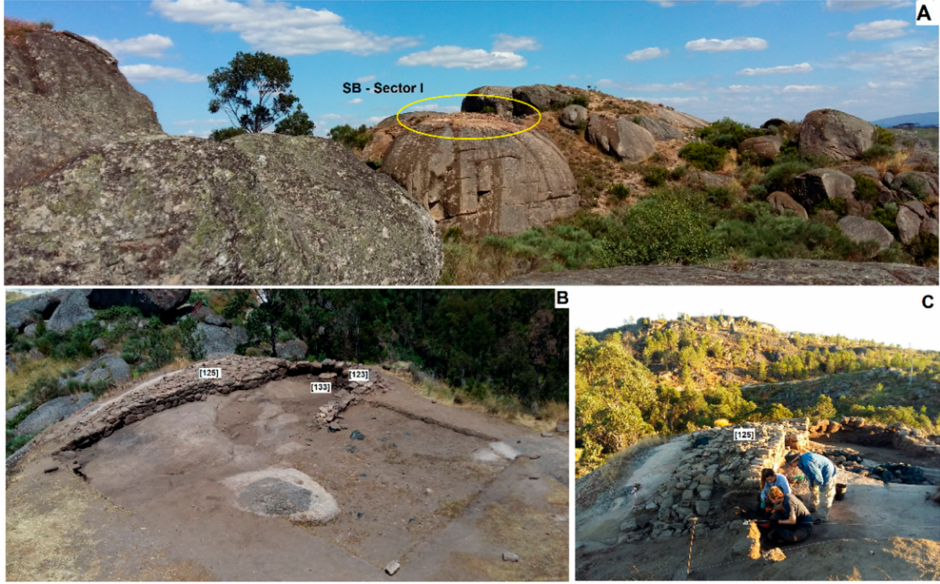
Figure 2. Sector 1 implantation ( A ); Sector 1 overview ( B ); wall 112 dismantling ( C